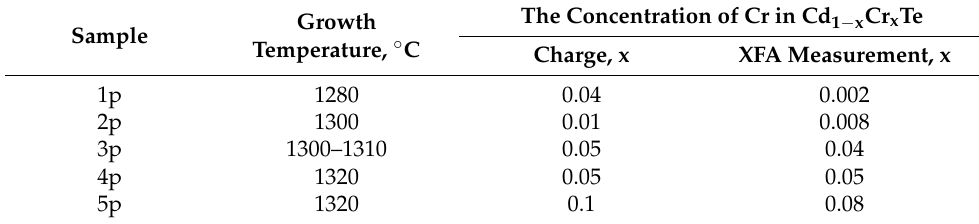
Table 1. Samples